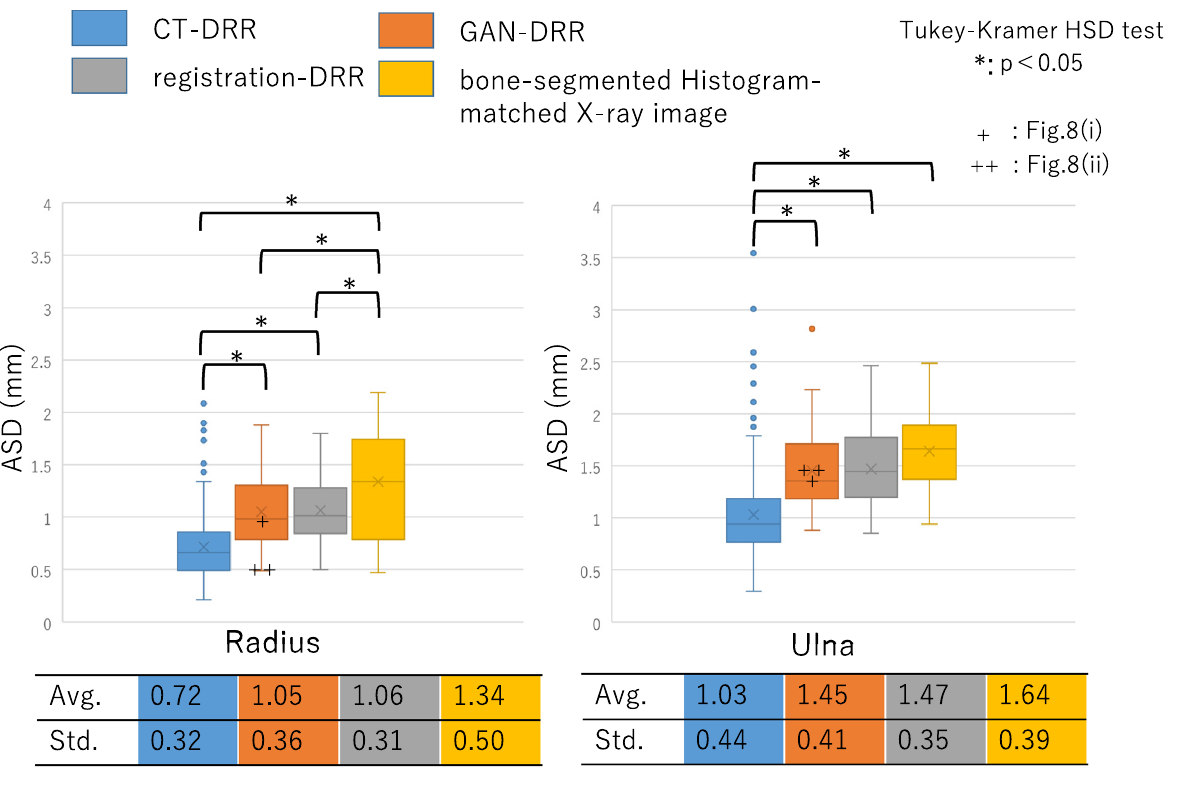
Figure 7. Experiment evaluating the relationship between image translation accuracy and 2D–3D reconstruction